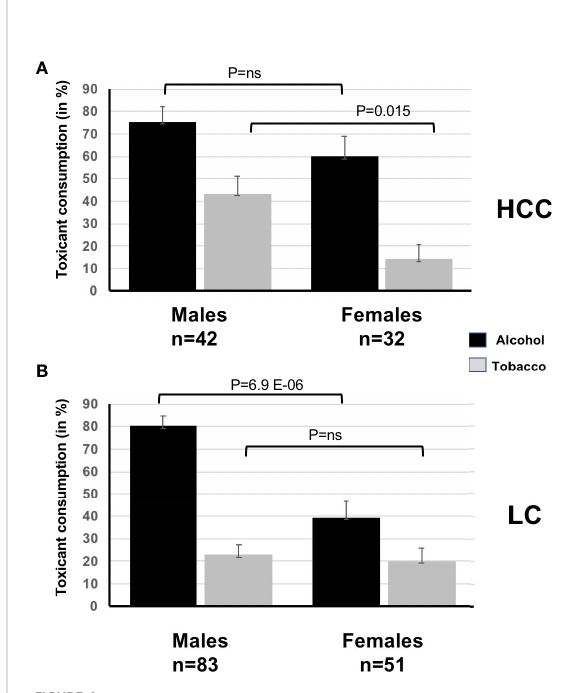
FIGURE 4 (A) , Prevalence of toxic risk factors (ethanol and tobacco)